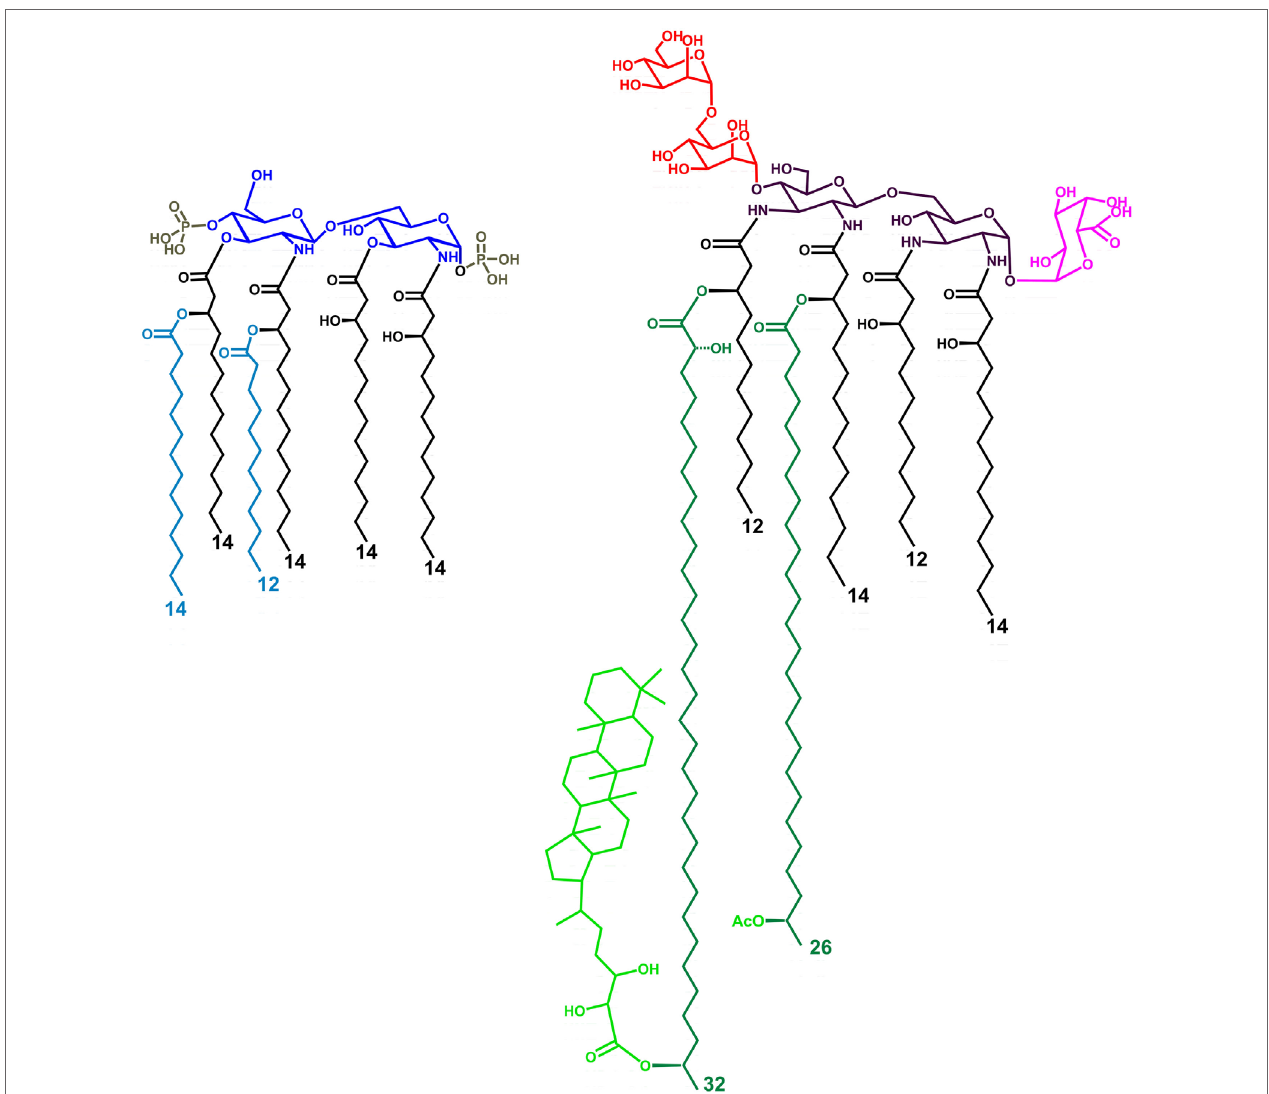
FigUre 1 | Structure of the LPS lipid A from Escherichia coli (left) and Bradyrhizobium strains (right, HOLA). The tetra-acylated lipid A from E. coli (lipid IV A ) lacks the two secondary acyl chains (light blue colored in the figure). HF-LA refers to hopanoid-free Bradyrhizobium lipid A and is devoid of the Hopanoid moiety (light green). The hexa-acylated lipid A from E. coli contains a bis -phosphorylated glucosamine disaccharide backbone, asymmetrically substituted by six acyl chains. Bradyrhizobia lipid A is mainly constituted of a mixture of hexa- and hepta-acylated species, possesses a 2,3-diaminoglucose (DAG) disaccharide backbone, a galacturonic acid residue on the vicinal DAG and an α -(1 → 6)-mannose disacchaccaride on the distal DAG . The acyl chains are asymmetrically distributed on the sugar skeleton; of the two secondary very long-chain fatty acids present, one is not stoichiometrically substituted at ω -1 position by a hopanepolyol